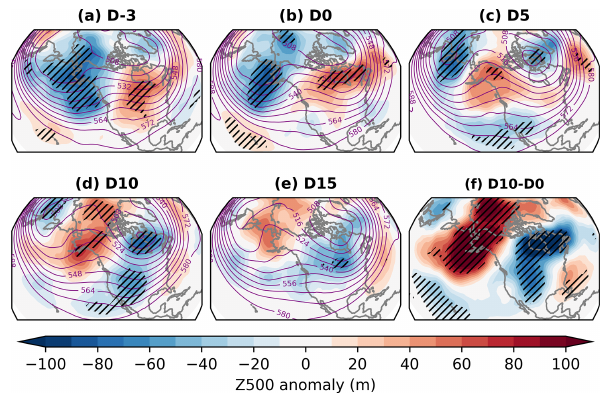
Figure 7. (a–e) Composite-mean 500hPa geopotential height (Z500) (purple contours, dam) and anomalies (shading, m) at vari- ous lags relative to the reflection event onset. (f) Average difference between the Z500 anomalies on day 10 and day 0 (i.e. d – b ). Hatch- ing denotes statistically significant anomalies, assessed as described in Sect.